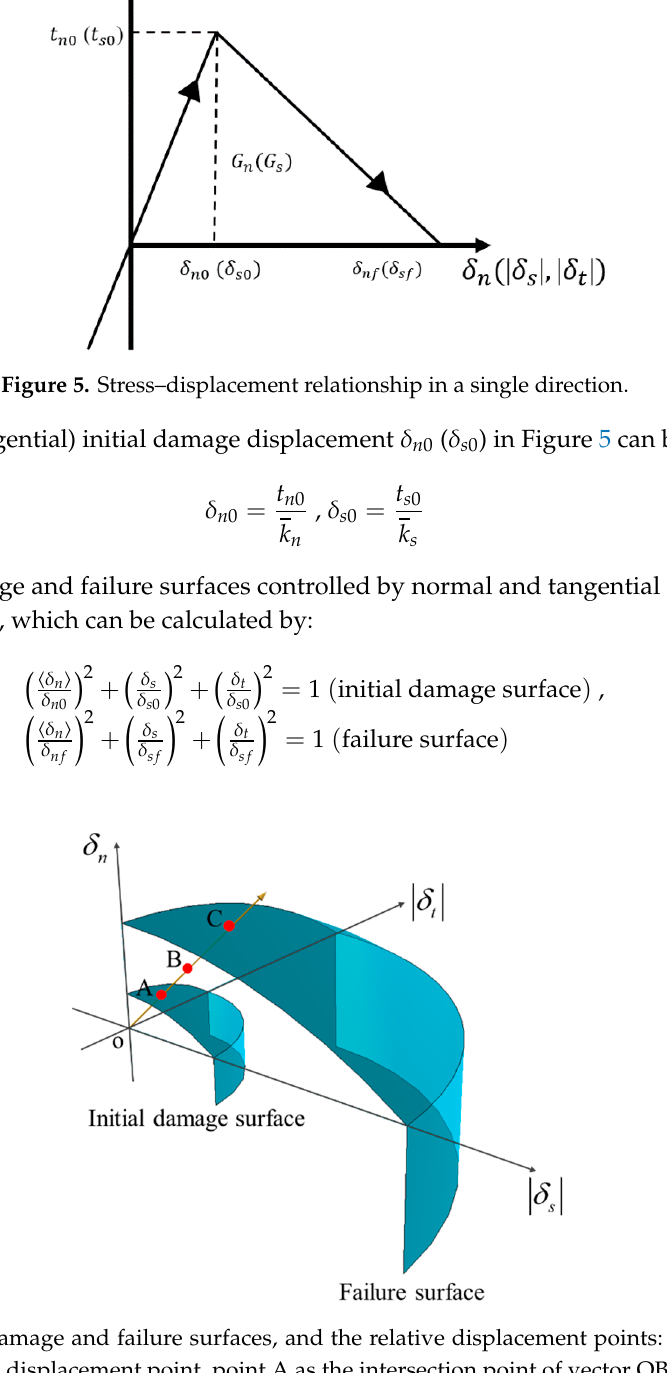
Figure 5. Stress–displacement relationship in a single direction.